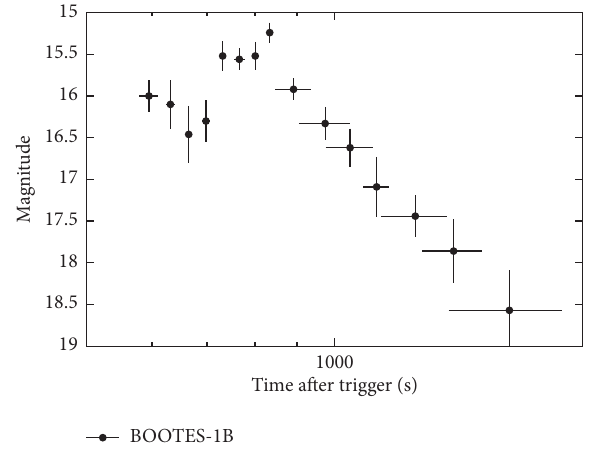
Figure 9: The optical light curve of GRB 101112A.